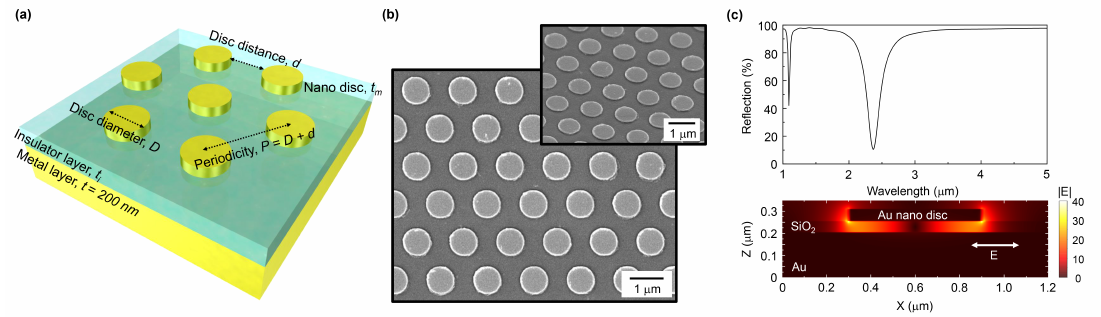
Figure 1. ( a ) Schematics of the metal–insulator–metal (MIM) metasurface with definition of the geometrical parameters. ( b ) SEM image of the fabricated metasurface; inset shows a 45 ◦ -tilted view SEM image. ( c ) Finite-difference time-domain (FDTD) simulated reflection spectrum of